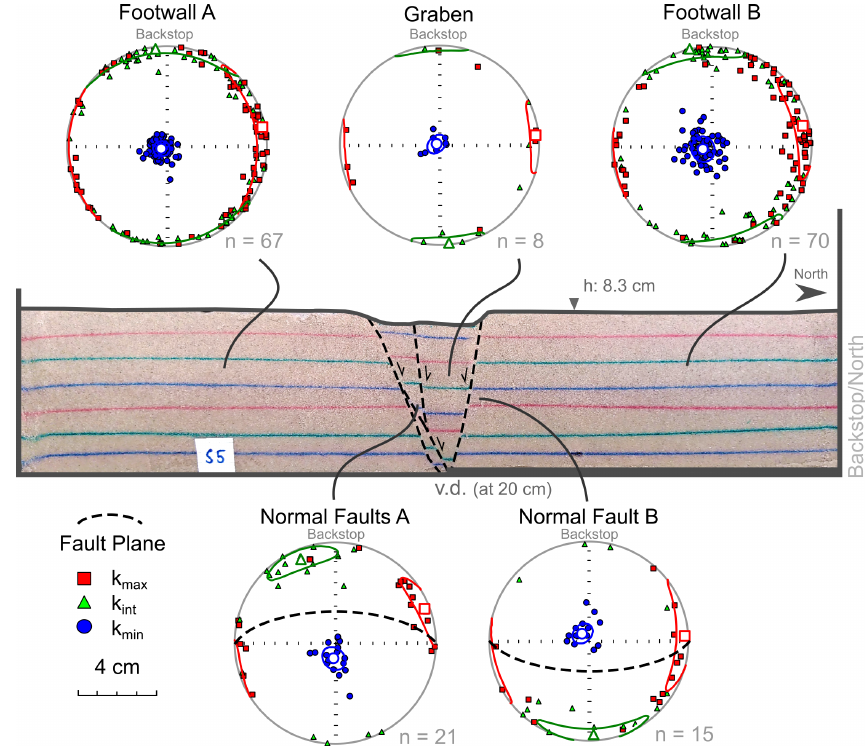
Figure 2. Representative section of Model I shows a graben that is bounded by normal faults (orange lines). The magnetic fabric for each structure/area is plotted on equal-area lower-hemisphere projections with the confidence ellipses and mean of each principal